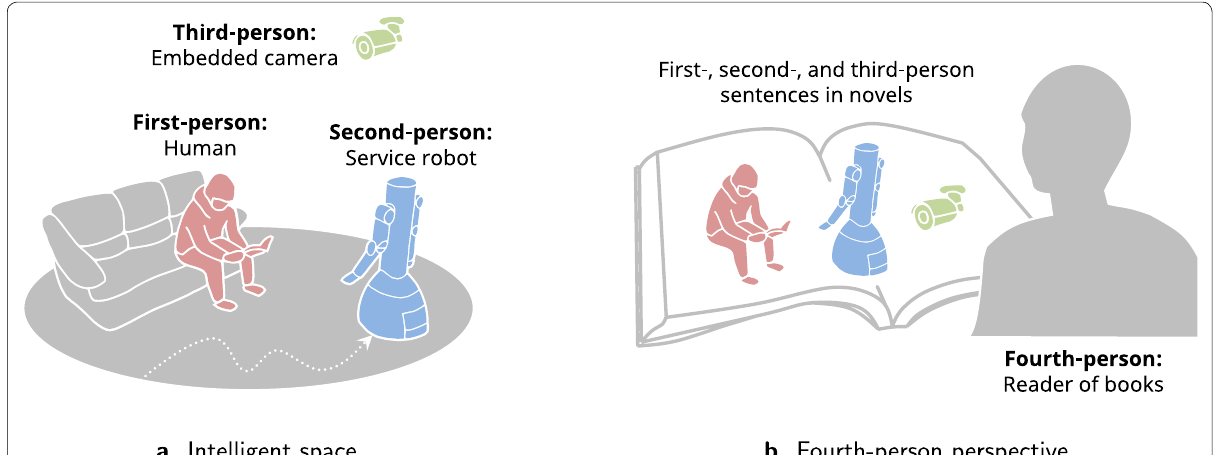
Fig. 1 The fourth-person perspective in the intelligent space. The “fourth-person” is a concept of the omniscient perspective which complementary combines the first-, second-, and third-person information acquired in the intelligent space